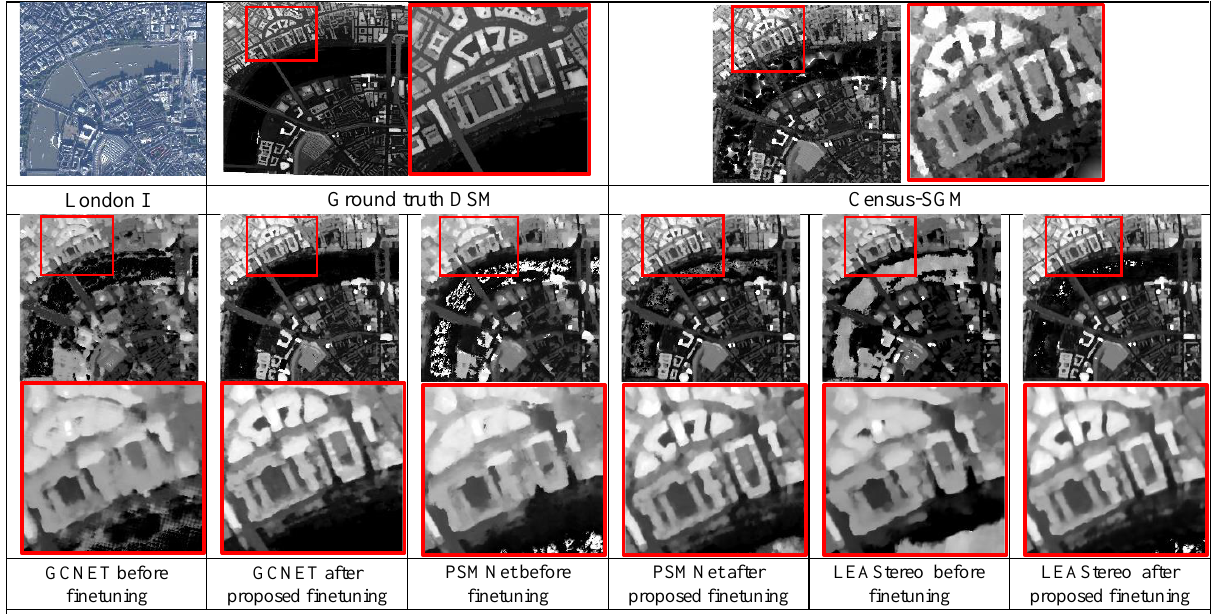
Figure 4. The DSMs from London I study sites before and after the proposed finetuning method. The enlarged image in the red rectangles indicates areas with a major improvement.